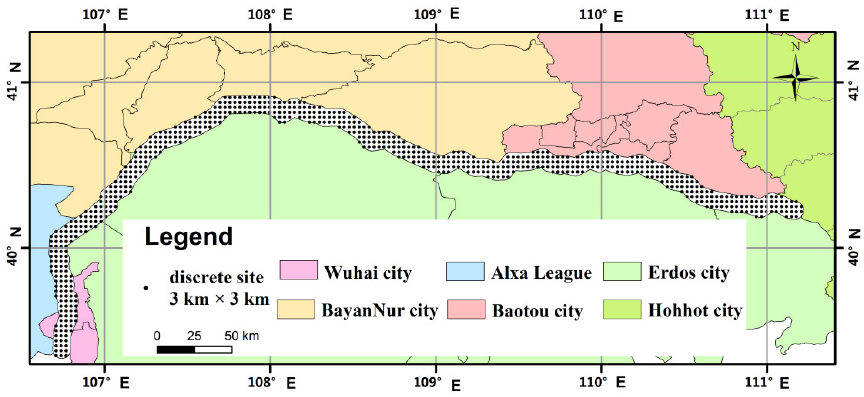
Figure 2. Distribution of discrete points in Inner Mongolia section of the Yellow River.